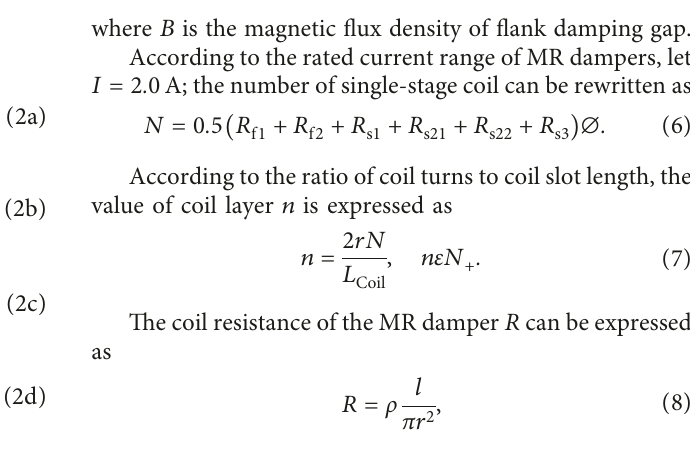
Figure 2: MR damper entity structure model.